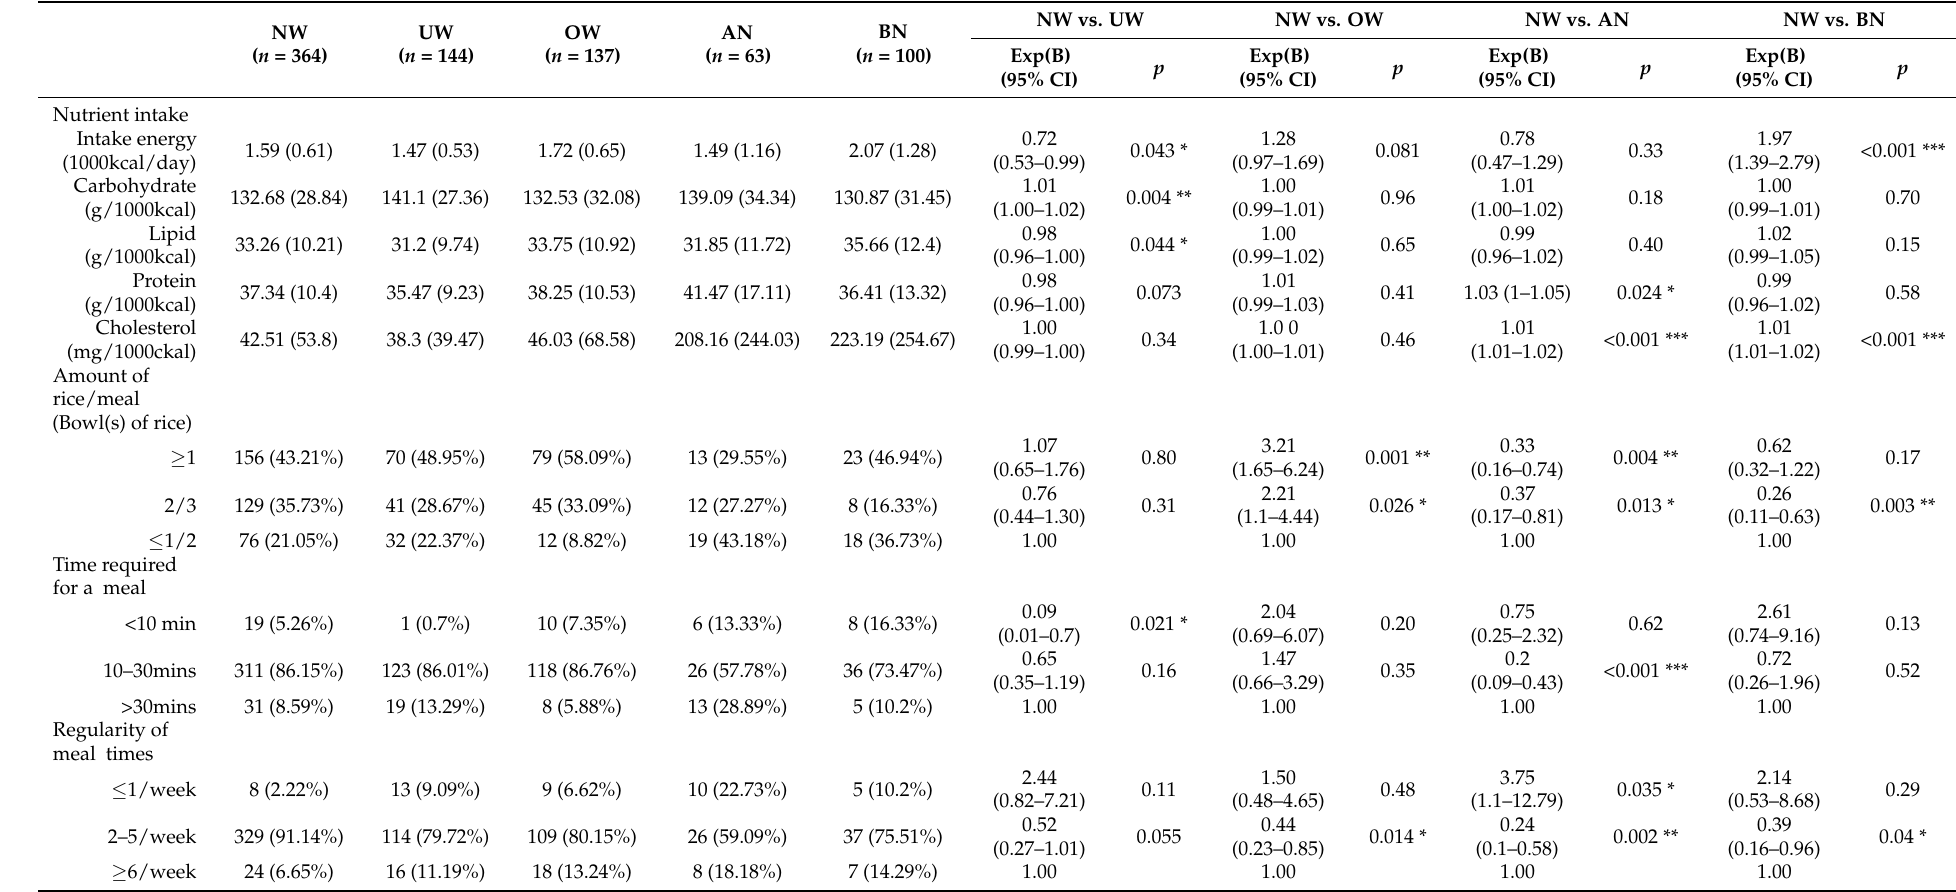
Table 2. Nutrient intake and dietary habits of young women with UW and OW, and patients with AN and BN compared to women with